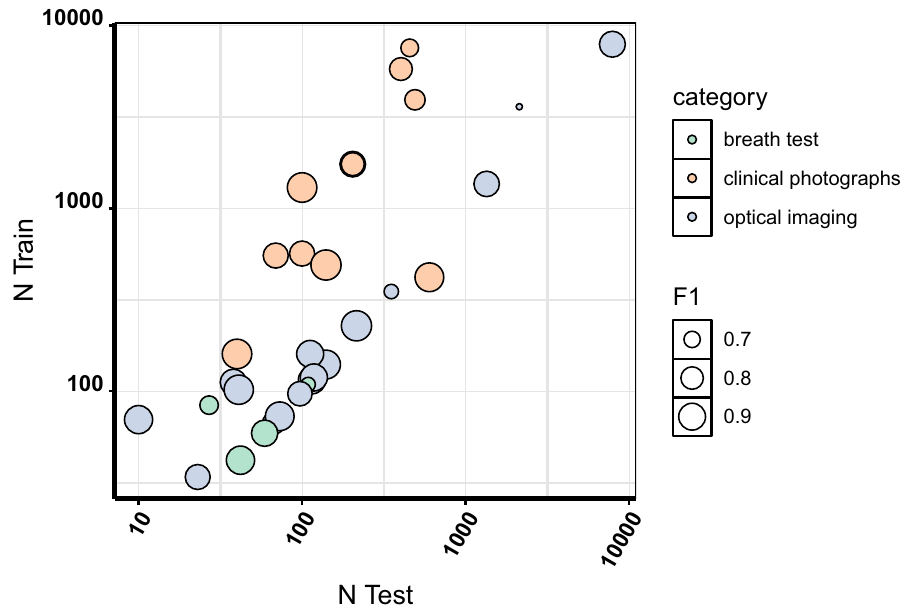
Figure 5. overview of training and validation sample sizes for identified studies included in meta-analysis. Point size proportional to F 1 score, indicating no obvious relationship between size of training sample here and